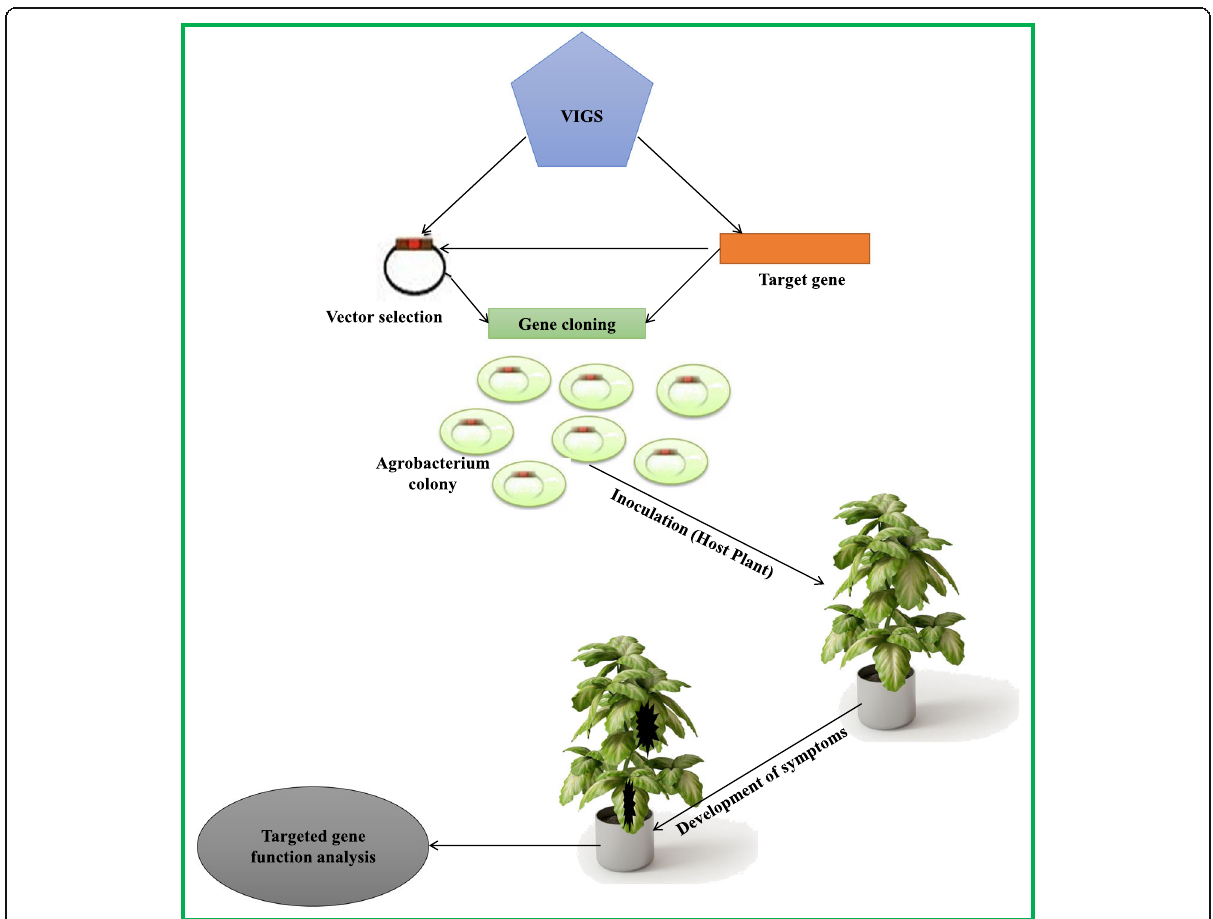
Fig. 4 Method for high-throughput virus-induced gene silencing (VIGS). VIGS is performed by cloning a short stretch of sequence (usually 100 – 500 base pairs) from a candidate gene or random cDNAs into a virus genome under the control of promoter within a binary